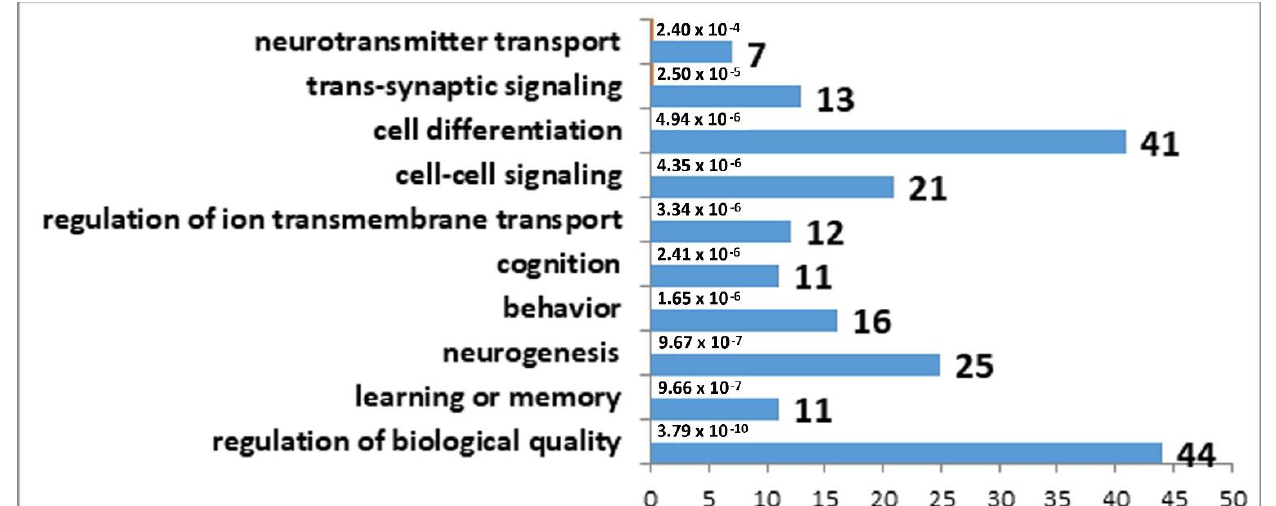
Figure 1. GO terms linked with the DEGs that correlated with Tph2 expression in the MRN transcriptome analysis of the winners. The horizontal axis represents the number of genes.